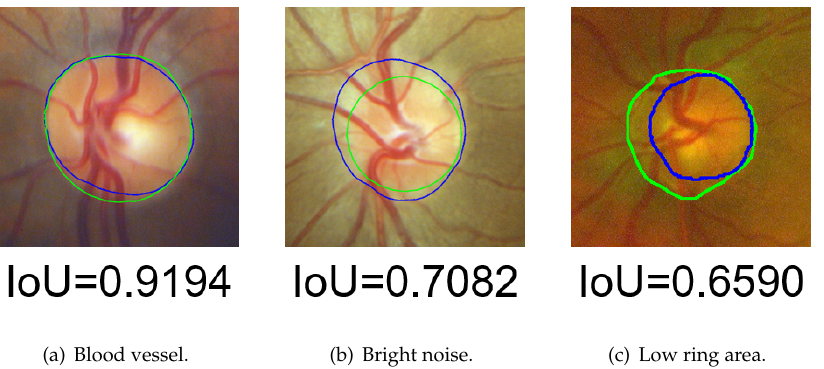
Figure 25. Unsolved problems in OD segmentation (green contour: GT, blue contour: segmenta- tion results).